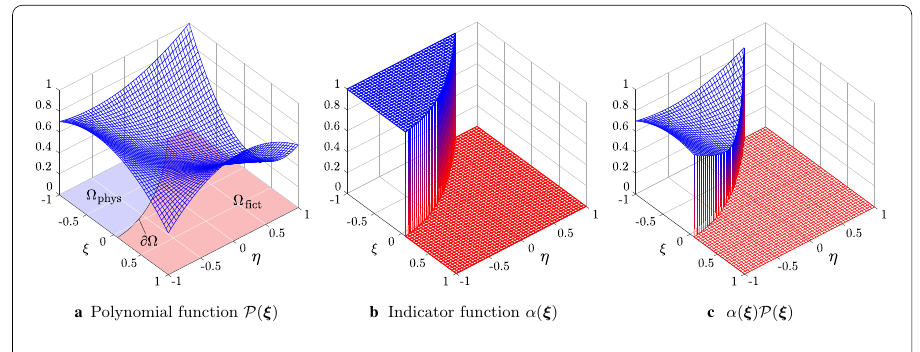
Fig. 2 A two-dimensional example of a discontinuous integral in the FCM, where the polynomial integrand + 0 . 4 N + 0 . 6 N + 1 N + 0 . 8 N + 0 . 8 N + 0 . 2 N + 0 . 7 N + 0 . 4 N P ( ξ , η ) = 0 . 7 N 1 2 3 4 5 6 7 8 9 is defined by a linear combination of the 3rd-order Lagrangian shape functions based on an equidistant nodal